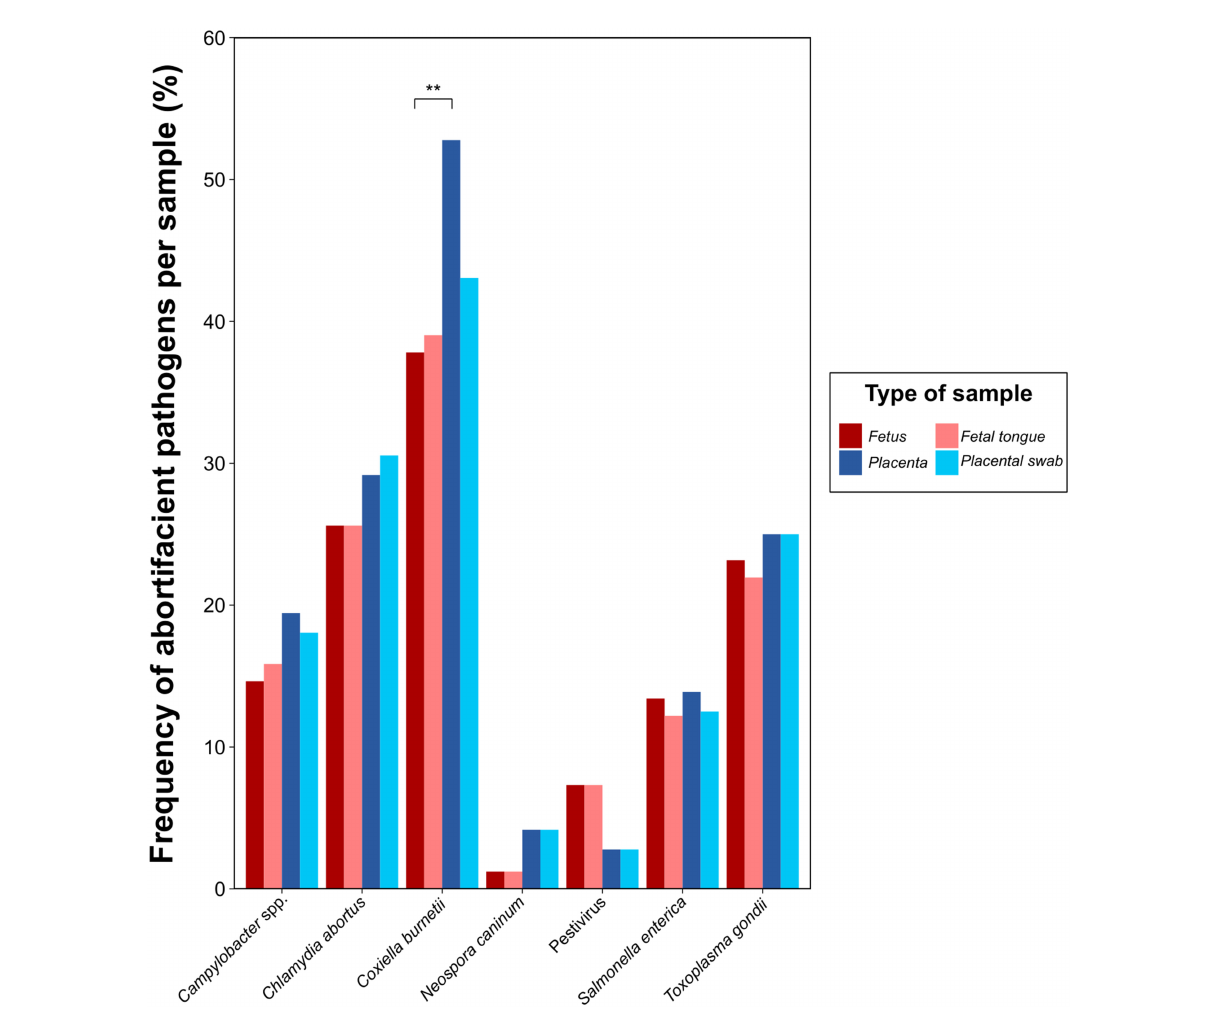
FIGURE4 Frequency of abortifacient pathogens in small domestic ruminants in a selection of 98 clinical cases referred to the diagnostics laboratory from April 2020 to May 2021 for the comparison of the classical (fetus and placenta) and the alternative sampling method (fetal tongue tissue and placental swab) for molecular diagnosis. The level of statistical significance was represented with asterisks: two asterisks (**) indicated a p -value between 0.001 and 0.01; one asterisk (*) indicated a p-value between 0.01 and